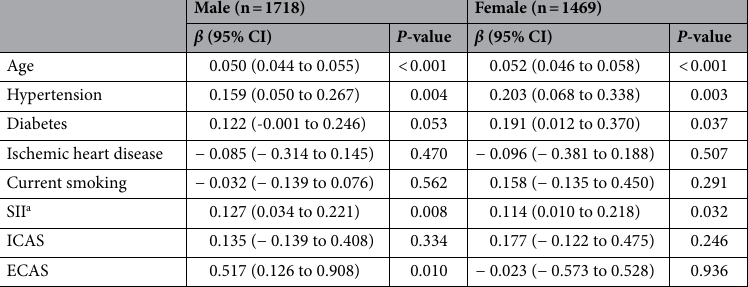
Table 3. Multivariable linear regression analysis of possible predictors for white matter hyperintensity volume (these variables were transformed into square root scales) according to the sexual difference. SII systemic immune-inflammation index, ICAS intracranial atherosclerosis, ECAS extracranial atherosclerosis. a These variables were transformed into log